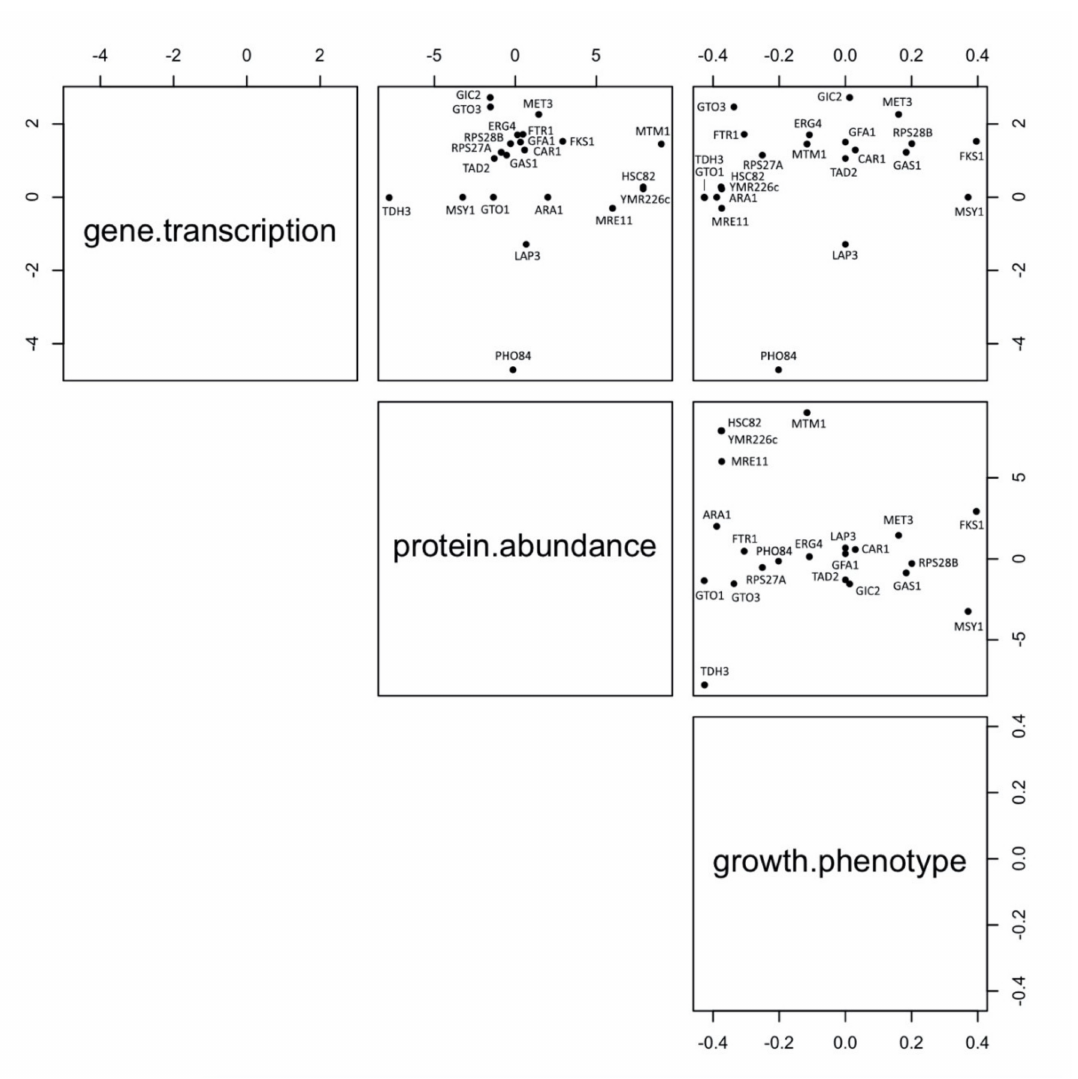
Figure 10. Scatterplot matrix of the independent variables: transcriptome, proteome, and phenome. Three-dimensional scatterplot representing the correlation among gene expression, protein abundance and growth phenotype. Phenomics data are taken from Marmiroli et al., 2016, transcriptomics data from Pagano et al.,